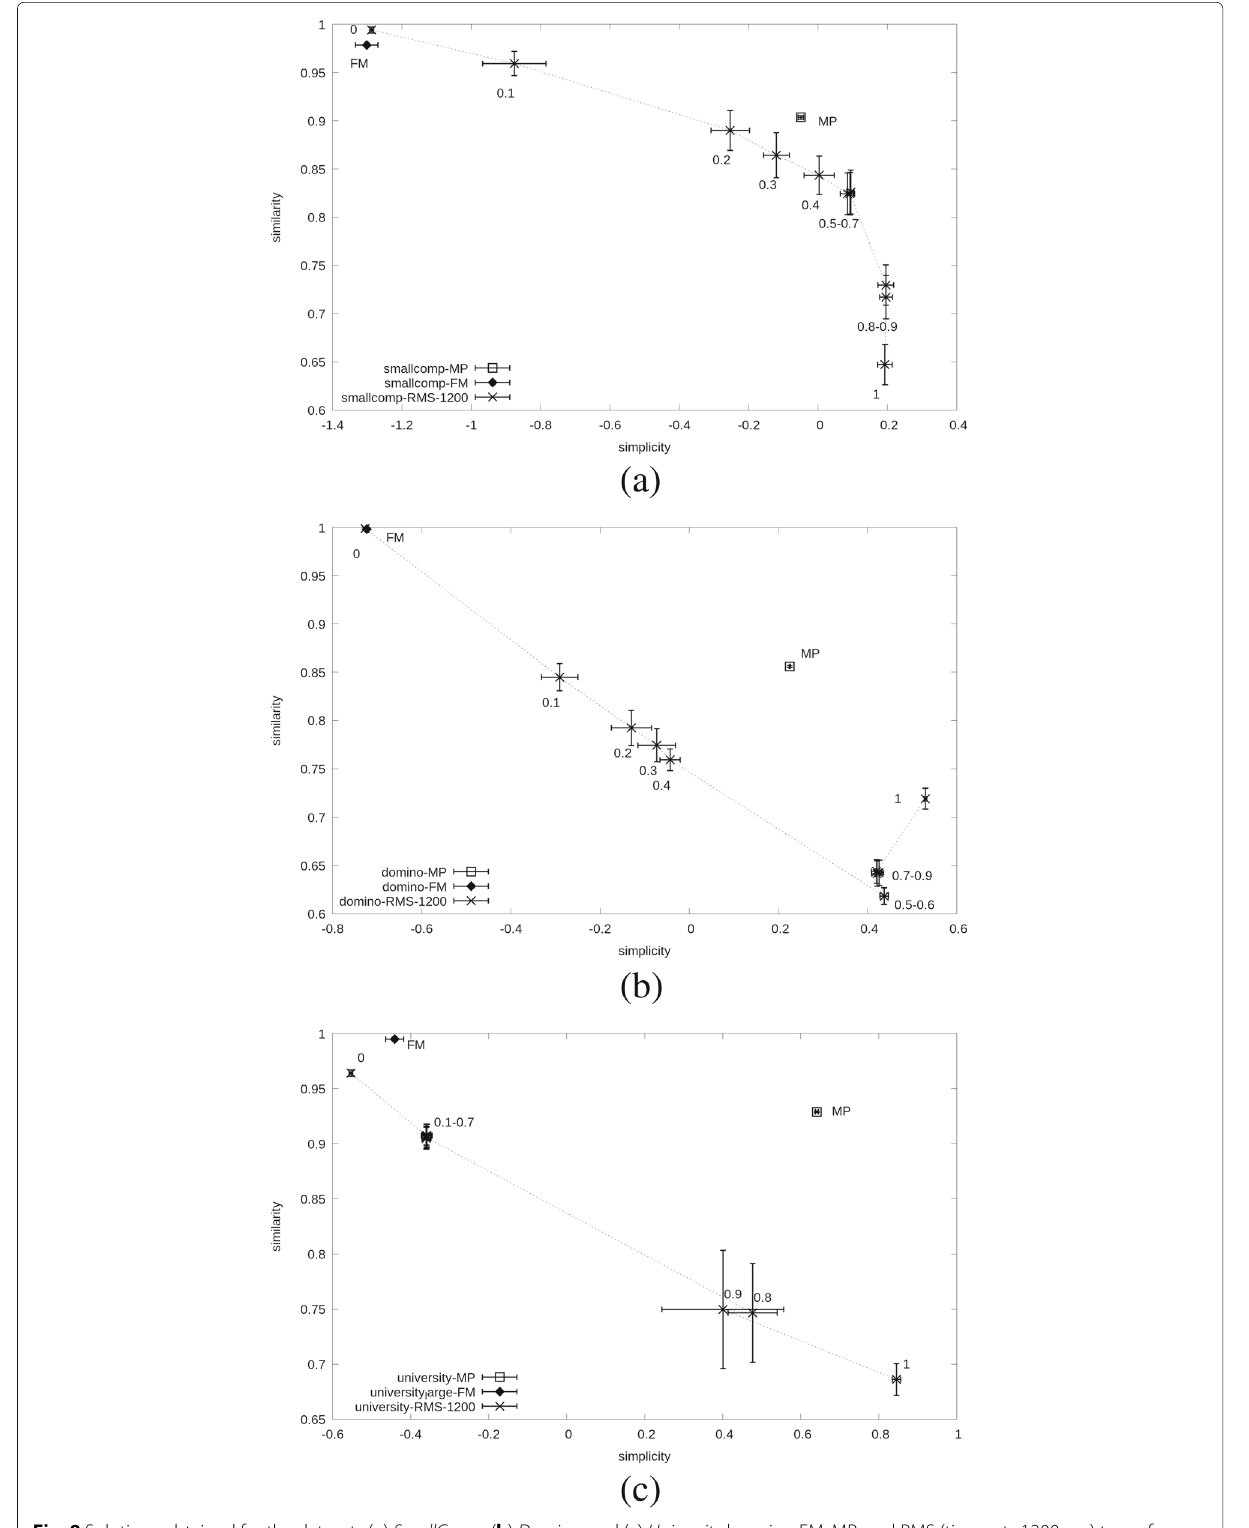
Fig. 8 Solutions obtained for the datasets ( a ) SmallComp , ( b ) Domino , and ( c ) University by using FM, MP, and RMS (timeout=1200 sec) to perform RBAC maintenance tasks. For RMS, different values of the balancing parameter are plotted (sampled at regular intervals over 0.0 − 1.0 with step 0.1). Solutions are positioned according to their average simplicity (x axis) and similarity (y